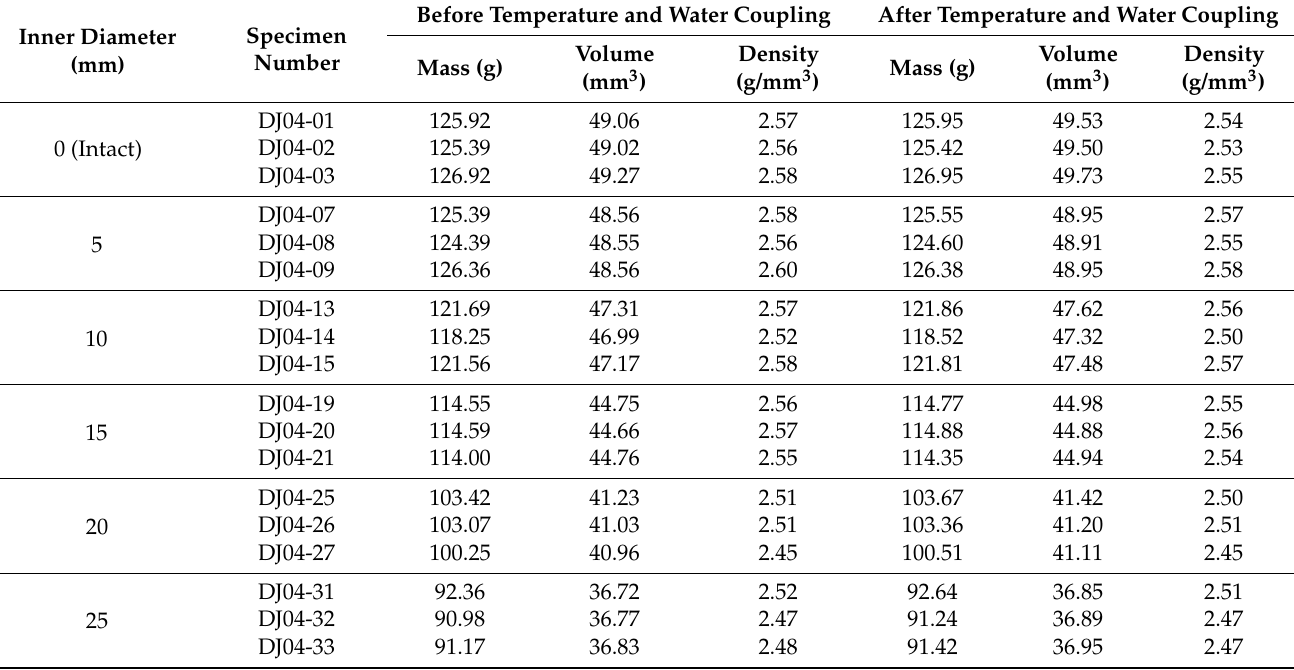
Table 1. Comparison of physical data before and after temperature-water coupling.